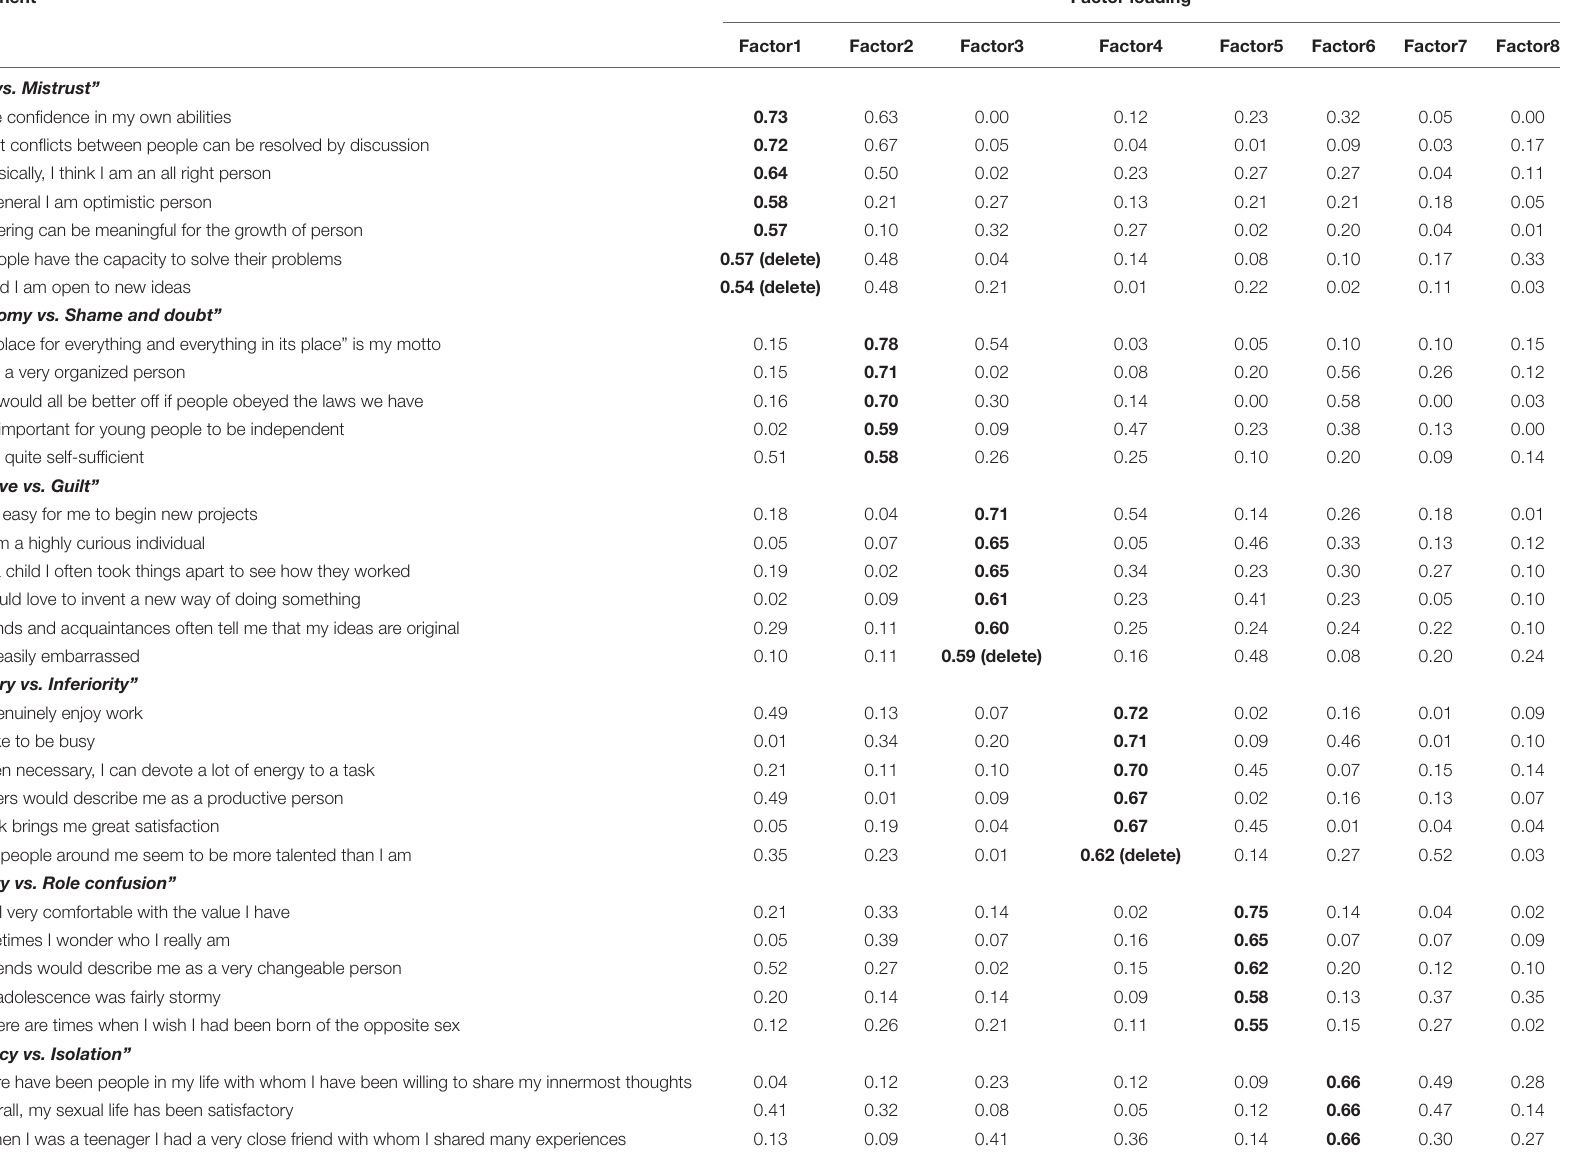
TABLE 2 | Factor analysis of C-IPB ( N =